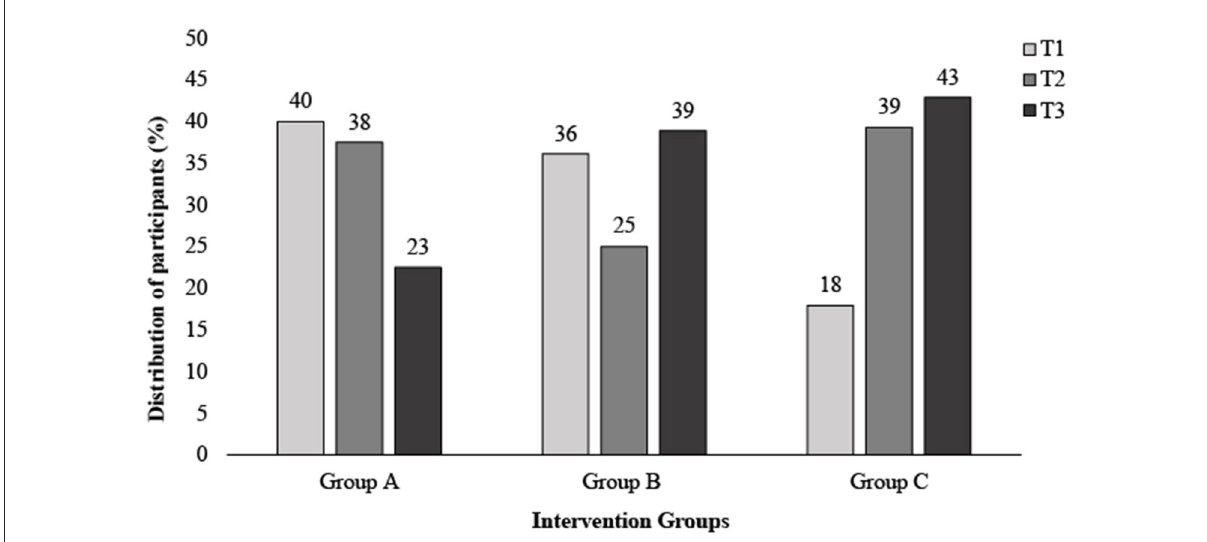
FIGURE2 Distribution of participants across tertiles of total cholesterol 1 (%) following 6 weeks of a dairy fat intervention split by diet intervention group. 1 , delta; T1, Tertile 1; T2, Tertile 2; T3, Tertile